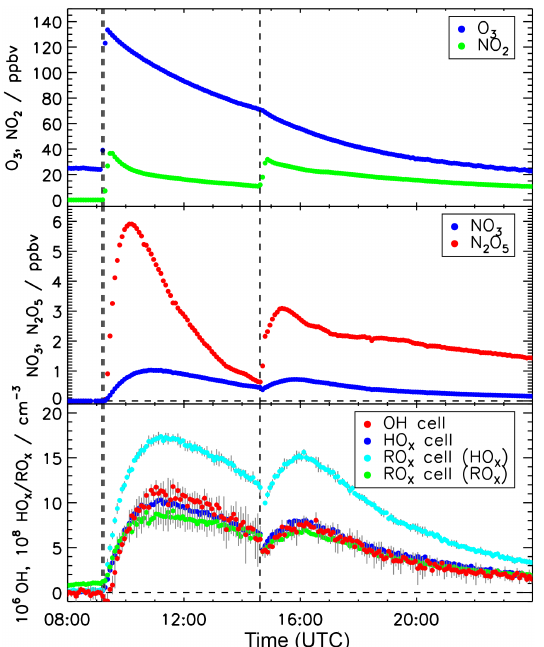
Figure 11. Measured apparent OH, HO x , and RO x concentrations (5min averages) during an experiment in the dark SAPHIR cham- ber, when only NO 2 and O 3 were injected in dry synthetic air. For differences between OH, HO x , and RO x detection, see description of the instrument. NO 3 and N 2 O 5 were measured by cavity ring- down spectroscopy. Concentrations in all LIF detection cells (in- strument with the short inlet) and measurement modes show similar time